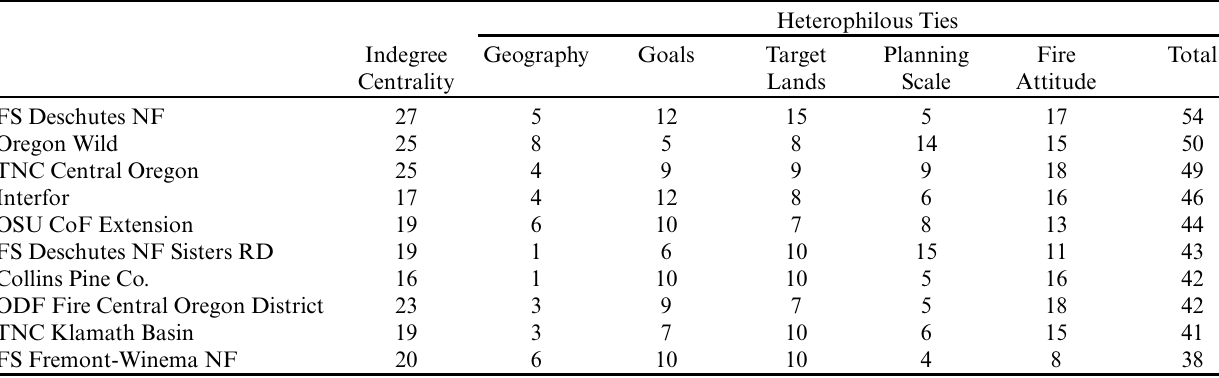
Table 3 . Top 10 organizations ranked by total number of heterophilous ties to working